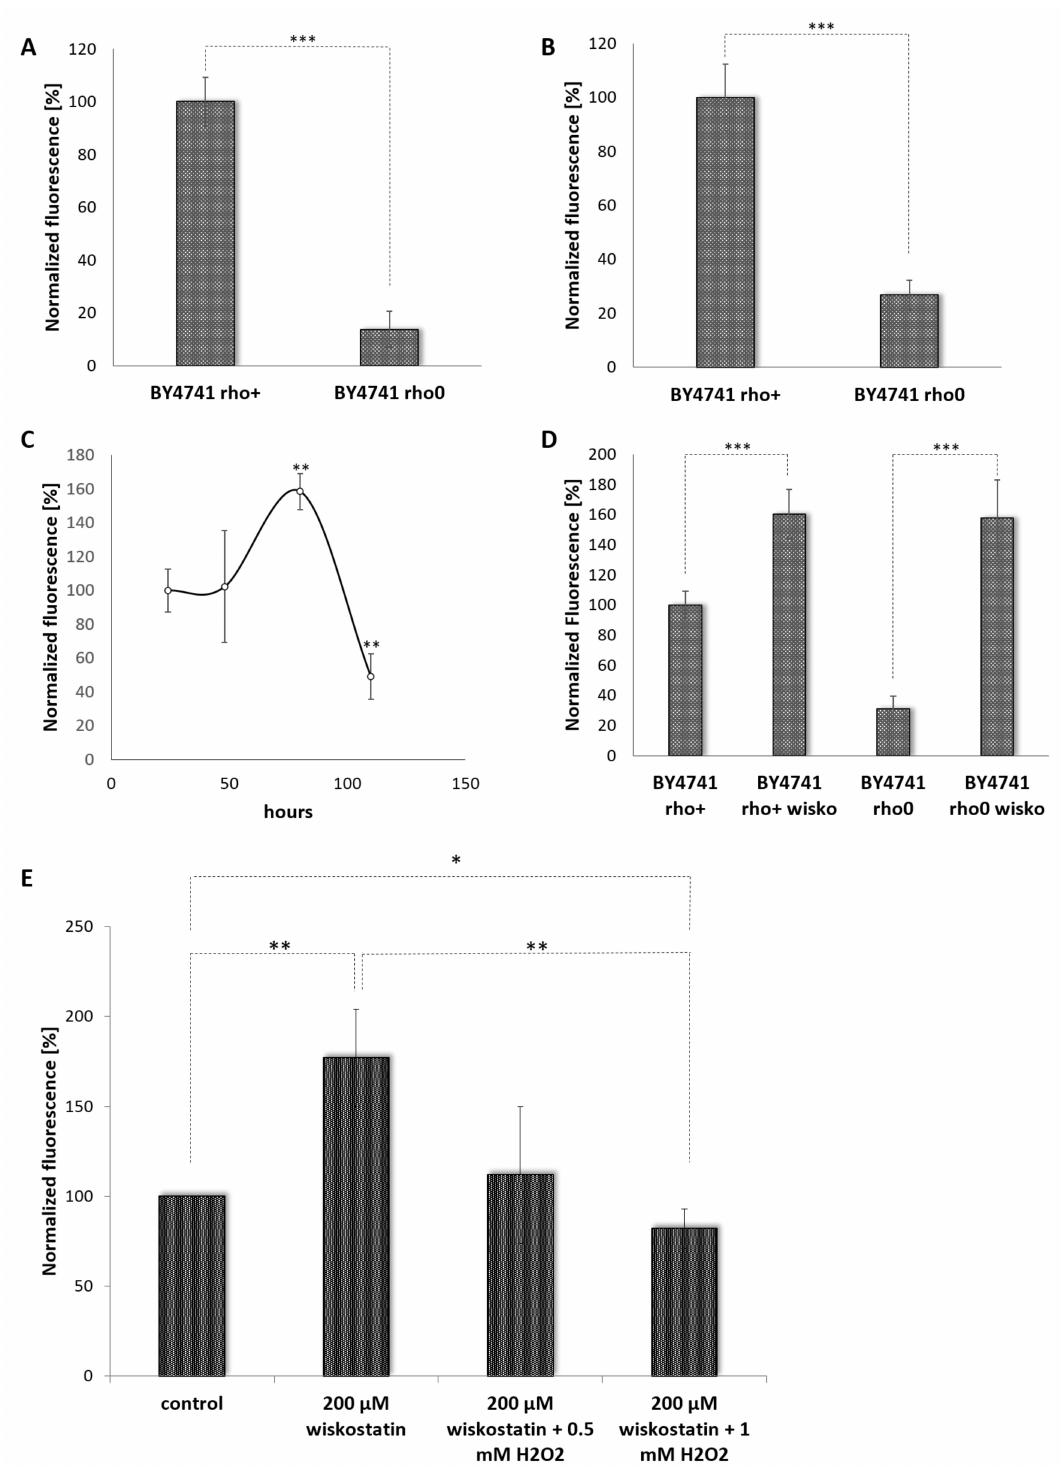
Figure 2. A GFP-based YNO1 -reporter. ( A ) Superoxide levels were measured by using the fluorescent probe DHE. The wild type strain BY4741 (rho + ) and the petite strain BY4741 (rho0) were analyzed (N = 4–7). In ( B – E ), the expression of YNO1 was studied by measuring GFP fluorescence. A GFP- HIS3 cassette was used to replace the native YNO1 ORF. In ( B ), the strains BY4741 ∆ yno1::GFP- HIS3 rho+ and BY4741 ∆ yno1::GFP- HIS3 rho0 were compared (N = 6). In ( C ), the expression of YNO1 was analyzed at the transition from late exponential phase to early stationary and stationary phase in the strain BY4741 ∆ yno1::GFP- HIS3 (N = 4). ( D ) shows the expression of YNO1 in the strains BY4741 ∆ yno1::GFP- HIS3 rho+ and BY4741 ∆ yno1::GFP- HIS3 rho0 after addition of 200 µ M wiskostatin (wisko, N = 4). In ( E ), wiskostatin (200 µ M)-induced expression of YNO1 is reversed by addition of 0.5 mM or 1 mM H 2 O 2 (N = 4) (*: p < 0.1; **: p < 0.05; ***: p <